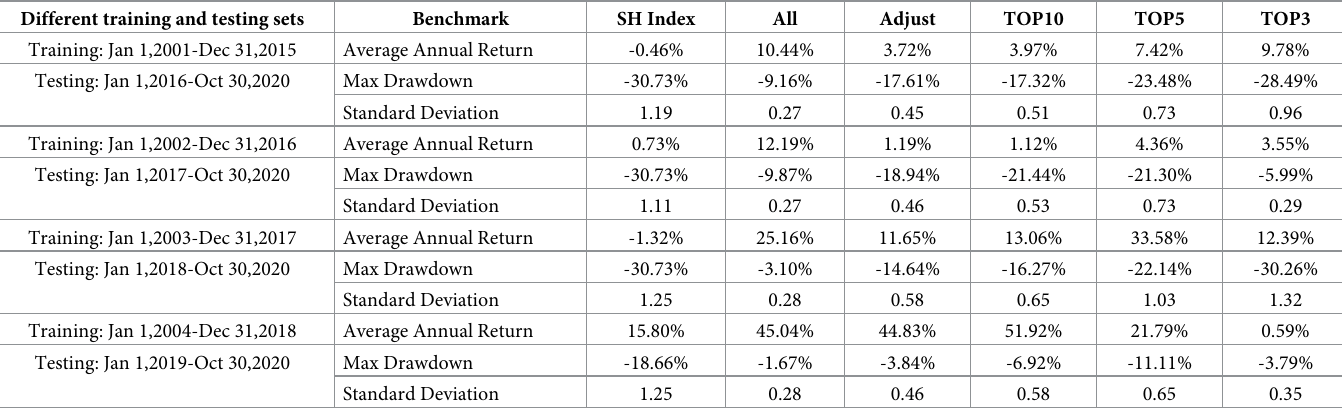
Table 7. Finance performance of sliding windows in two-day patterns predicting one day ahead. Different training and testing sets